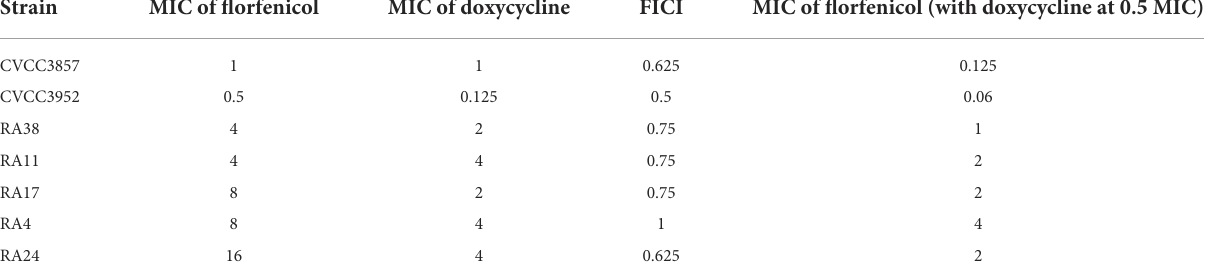
TABLE 1 Minimum inhibitory concentration (MIC) and fractional inhibitory concentration index (FICI) in in vitro susceptibility testing. Strain MIC of florfenicol MIC of doxycycline FICI MIC of florfenicol (with doxycycline at 0.5 MIC)